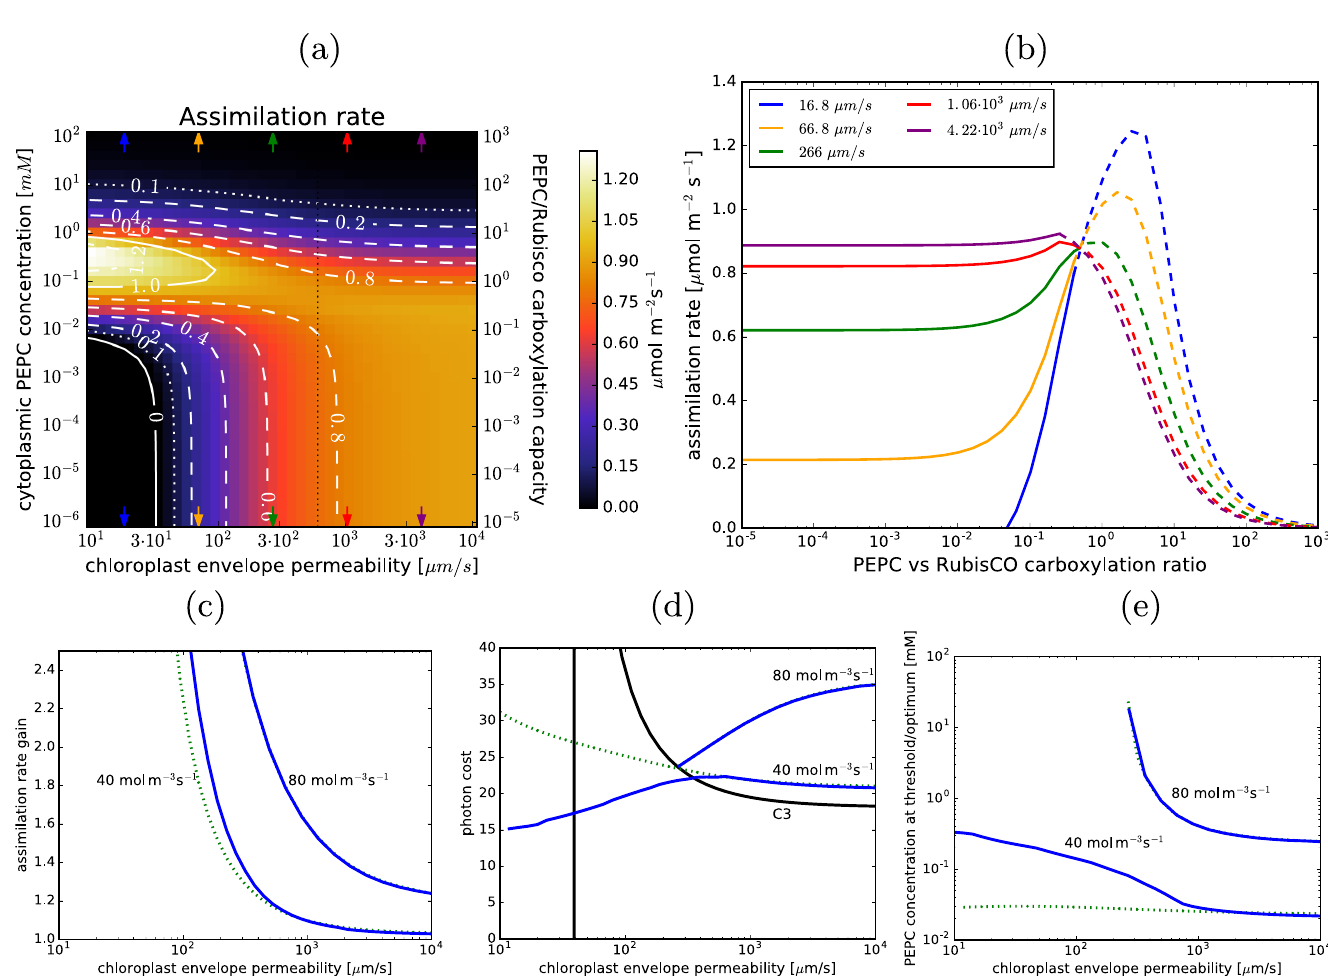
Fig 6. C 4 photosynthesis at limited light-harvesting capacity. (a): The net assimilation rate as a function of the envelope permeability and PEPC concentration in the cytoplasm when the light input is capped at 40 mol m -3 s -1 . Parameters as in Fig 2. The vertical dotted line marks the permeability used as default in other figures. (b): The assimilation rate vs PEPC-to-Rubisco carboxylation capacity ratio for several envelope permeability values (marked with arrows in a). The lines are dashed where the light use equals the harvesting capacity. (c): The relative gain in the assimilation rate (compared to C 3 photosynthesis) at the PEPC activity levels where the light usage reaches 40 mol m -3 s -1 and 80 mol m -3 s -1 (dotted green lines, corresponding to the green lines in Fig 2(b)) and the maximal assimilation gains (the maxima in panel (b)) when the corresponding light limits are imposed (blue lines). (d): the photon costs corresponding to assimilation gains in (c); the black line marks the cost of C 3 photosynthesis (below 40 μ m/s C 3 photosynthesis cannot reach the compensation point), the blue and green lines as in (c). (e): the respective PEPC concentrations at which the optimal gains are achieved in (c) and (d).